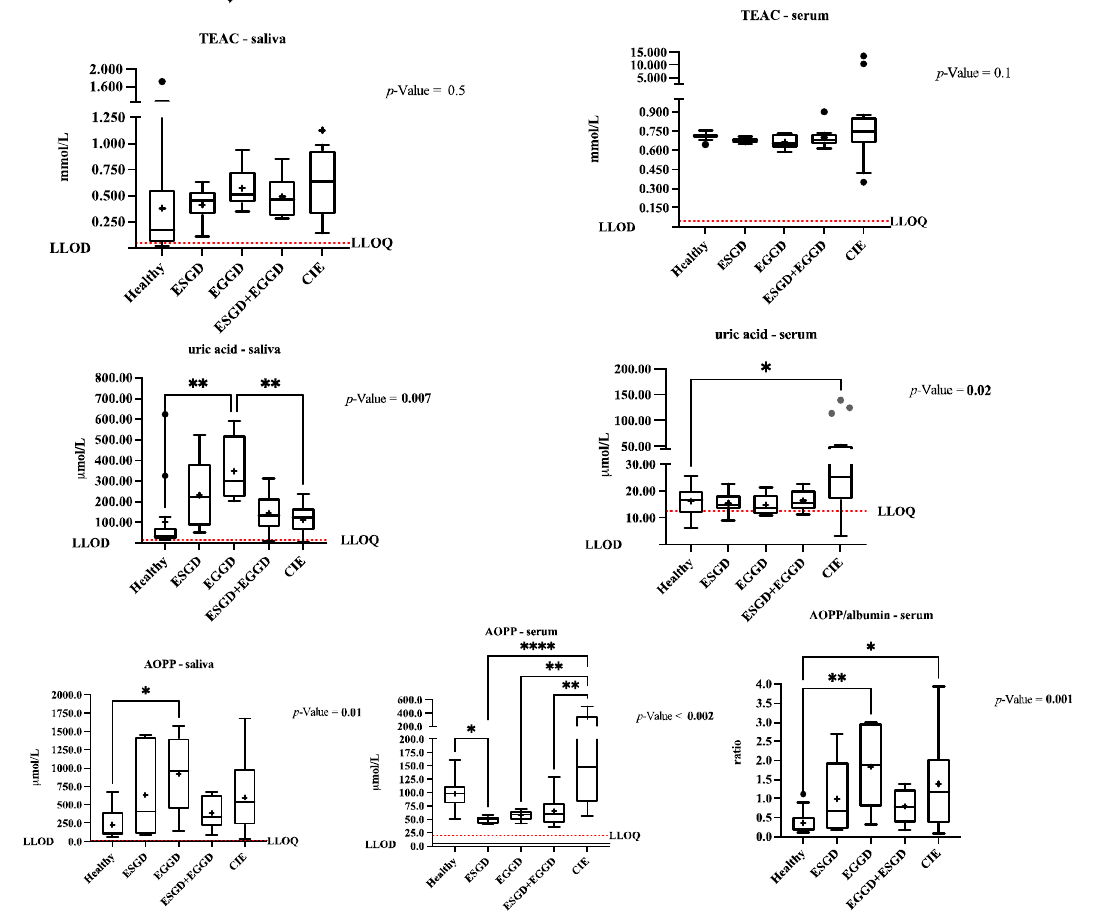
Figure 1. The ferric reducing ability of saliva/serum (FRAS/FRAP), cupric reducing antioxidant ca- pacity (CUPRAC), Trolox equivalent antioxidant capacity (TEAC), uric acid, and advanced oxidation protein products (AOPP) and ratio AOPP/albumin results in healthy horses ( n = 14), horses suffering Equine Squamous Gastric Disease (ESGD, n = 6), Equine Glandular Gastric Disease (EGGD, n = 8), ESGD + EGGD ( n = 9), and colic of intestinal aetiology (CIE, n = 22). The plot shows the median (line within box), mean (the cross inside the box), 25th–75th percentiles (box), 5th and 95th percentiles (whiskers), and outliers ( • ). The dotted and continuous lines show the lower limit of detection (LLOD) and the lower limit of quantification (LLOQ). Asterisks indicate statistically significant differences between groups (* p <0.05, ** p <0.01; *** p <0.001; **** p <0.0001). The line under the asterisks indicates the groups that showed significant